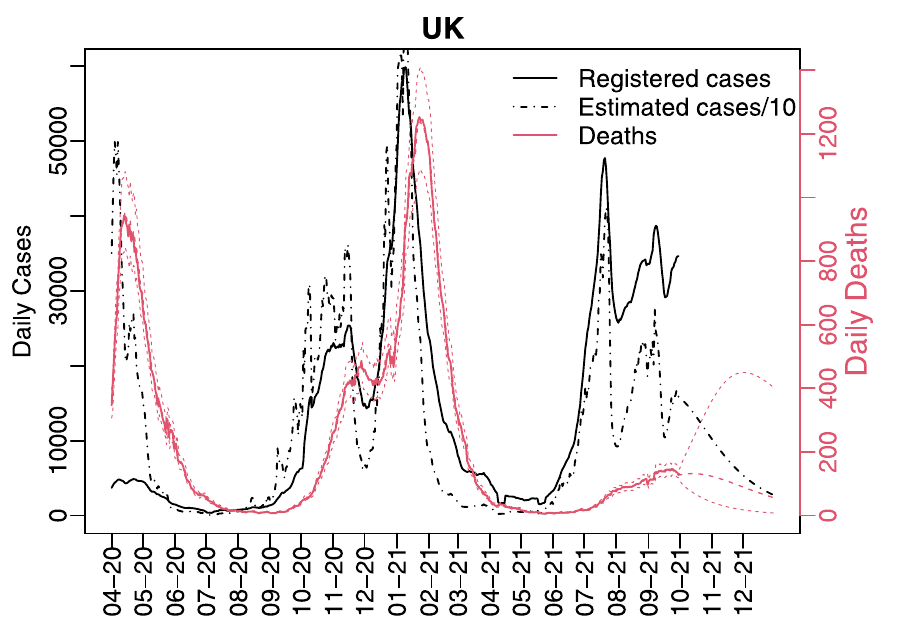
Fig 1. Daily 7-days moving average of new registered cases, estimated cases divided by 10 and